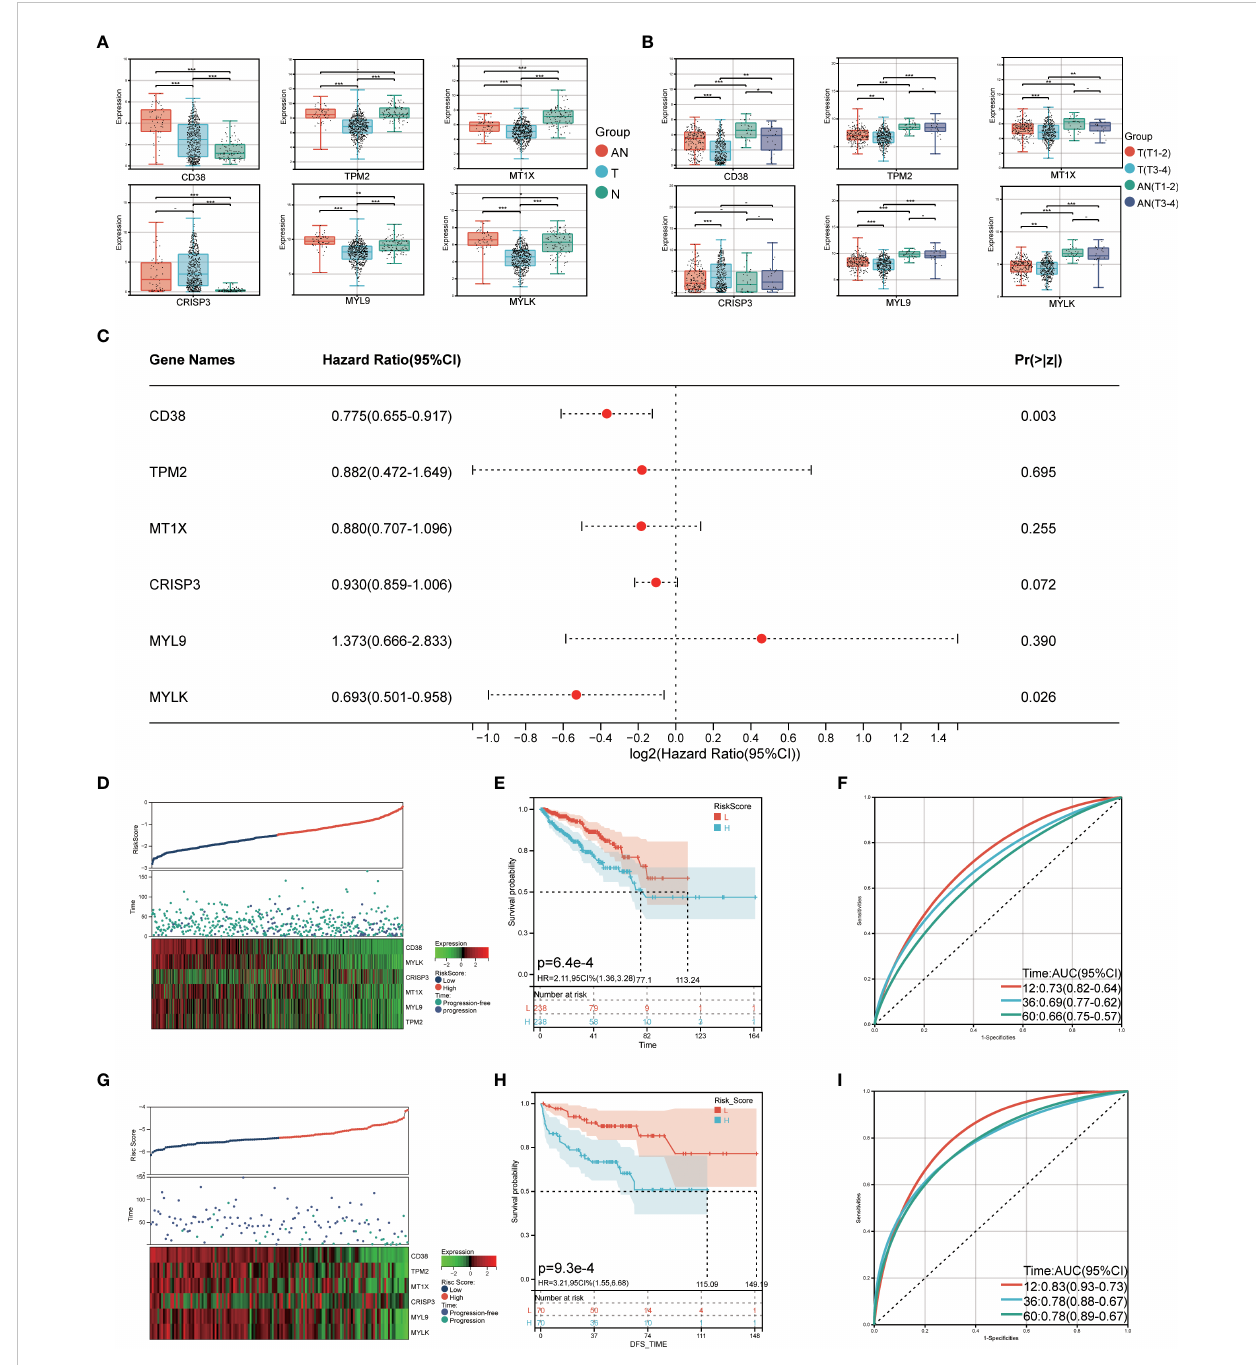
FIGURE 6 Construction of prognostic risk model. (A) expression level of LRHG in TCGA cohort in T, AN and N; (B) Expression of LRHG in TCGA cohort in non- invasive prostate cancer and invasive prostate cancer; (C) Forest map of multivariate Cox model of LRHG in risk score; (D) Expression of LRHG in TCGA cohort in low risk and high-risk population; (E) TCGA low-risk and high-risk population progression-free survival curve; (F) Time-dependent ROC curve of TCGA cohort; (G) Expression of LRHG in GSE21032 cohort in low risk and high risk population; (H) Progression-free survival curve of low-risk and high-risk population in GSE21032 cohort; (I) Time-dependent ROC curve of GSE21032 cohort. * P < 0.05; * * P < 0.01; *** P < 0.001. -: no relevant